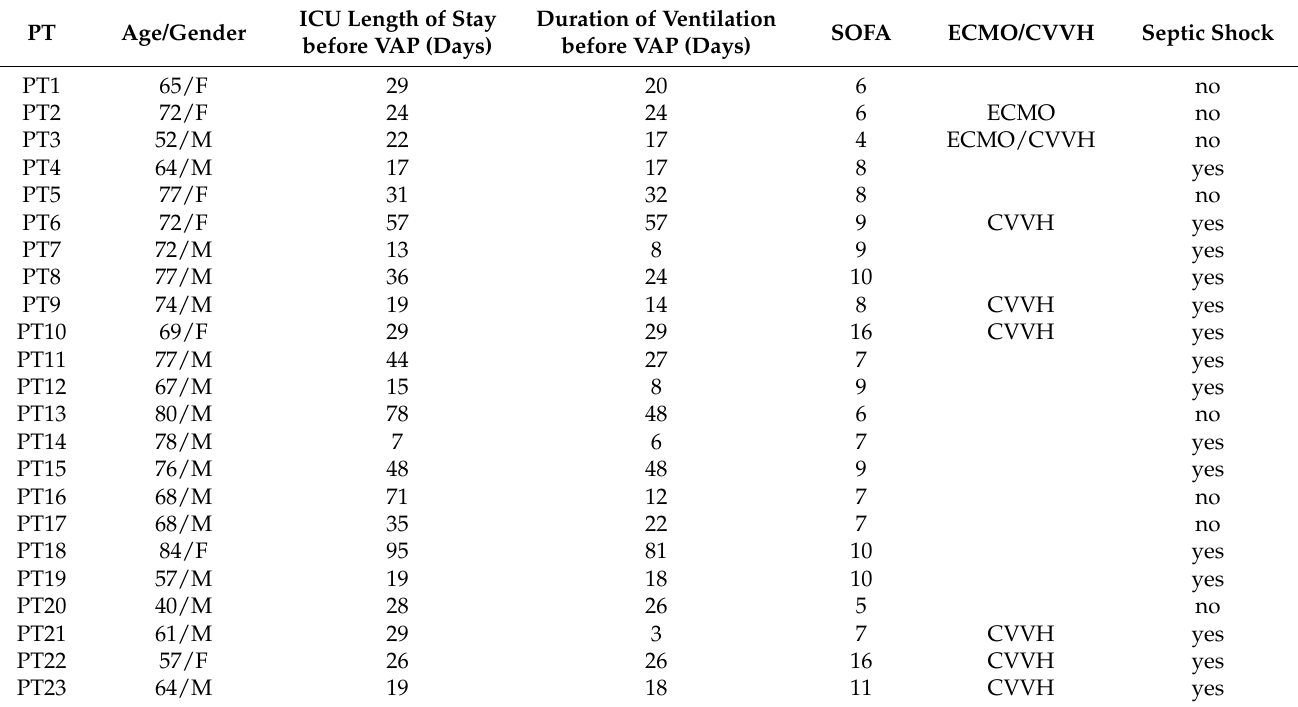
Table 1. Patient characteristics and clinical